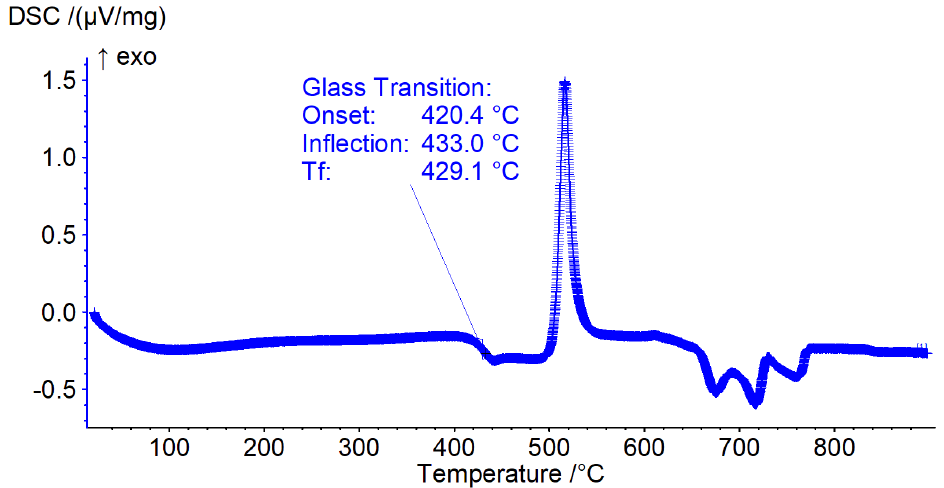
Figure 4. The representative DSC trace collected from the powder of the quenched glass of composition 9.